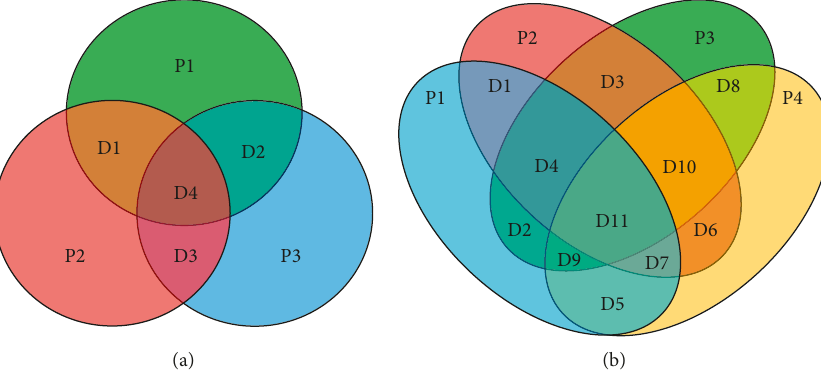
Figure 4: Parity vs data: Hamming (7, 3) (a) and Hamming (15, 11)